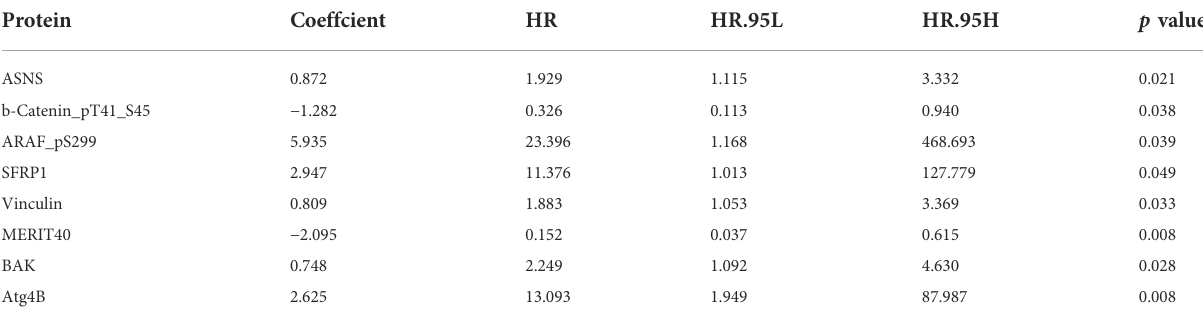
TABLE 1 The protein prognostic risk model.